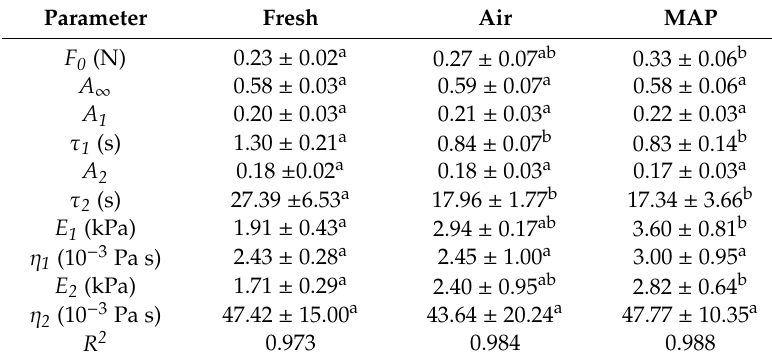
Table 5. Parameters of Maxwell generalized model ( A n , τ n ) and viscoelastic properties ( E n , η n ) of pasta (PB) at day 0 (fresh) and after 7 days of storage in air and MAP follow up MW heating (70 ± 5 ◦ C). Data were adjusted according by PLS regression, values in the same row with di ff erent letters are significantly di ff erent (Tukey’s LSD, p < 0.05).